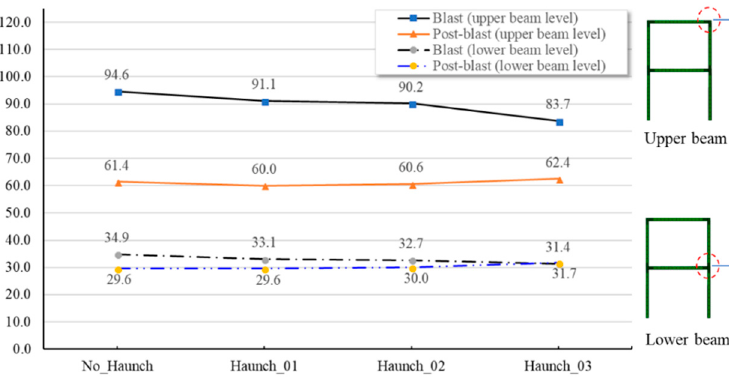
Figure 23. Maximum lateral displacement response.